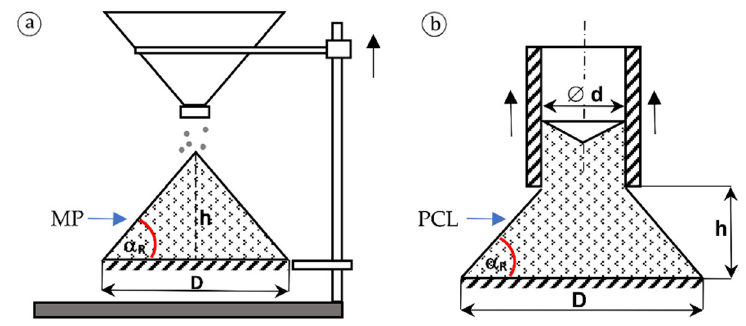
Figure 2. Scheme of the device measuring the angle of repose of: ( a ) microparticles, ( b ) particles of the core layer of particleboards.